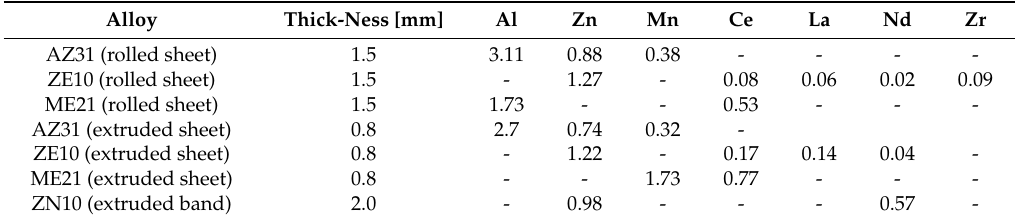
Table 1. Properties and chemical composition of sheets and band; values in wt %, Mg balance.